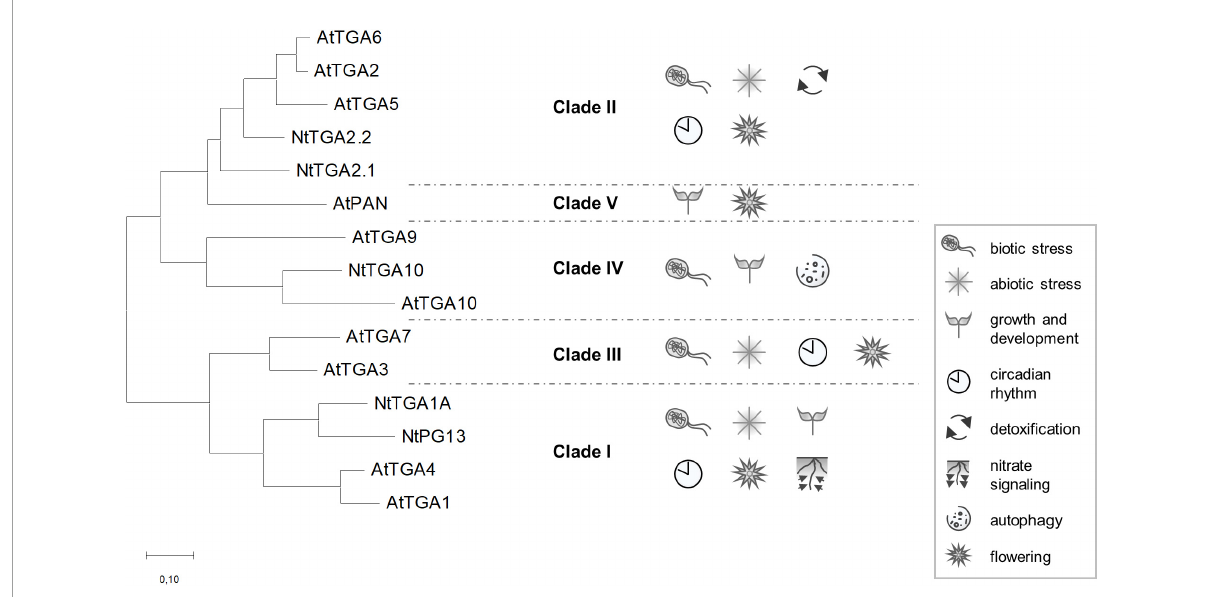
FIGURE1 Unrooted phylogenetic tree of Arabidopsis and tobacco TGAs. Phylogenetic analysis of TGA factors shows an earlier separation of clades into two branches, one dividing into clades II, IV, and V, the other into clades I and III, indicating a closer evolutionary relationship between clade members in the same branch. TGA involvement in regulation of different processes, based on literature search, is represented for each clade. Sequence alignment by MUSCLE (Edgar, 2004) and phylogenetic analysis by the Maximum Likelihood method, based on the JTT matrix-based model (Jones et al., 1992), were conducted in MEGA7 (Kumar et al., 2016). The branch length scale represents the number of substitutions per site. Protein sequences with listed protein identification numbers were retrieved from UniProtKB (https://www.uniprot.org/): AtTGA1 (Q39237), AtTGA2 (P43273), AtTGA3 (Q39234), AtTGA4 (Q39162), AtTGA5 (Q39163), AtTGA6 (Q39140), AtTGA7 (Q93ZE2), AtPAN (Q9SX27), AtTGA9 (Q93XM6), AtTGA10 (E3VNM4), NtTGA1A (P14232), NtPG13 (Q05699), NtTGA2.1 (O24160), NtTGA2.2 (Q9SQK1), and NtTGA10